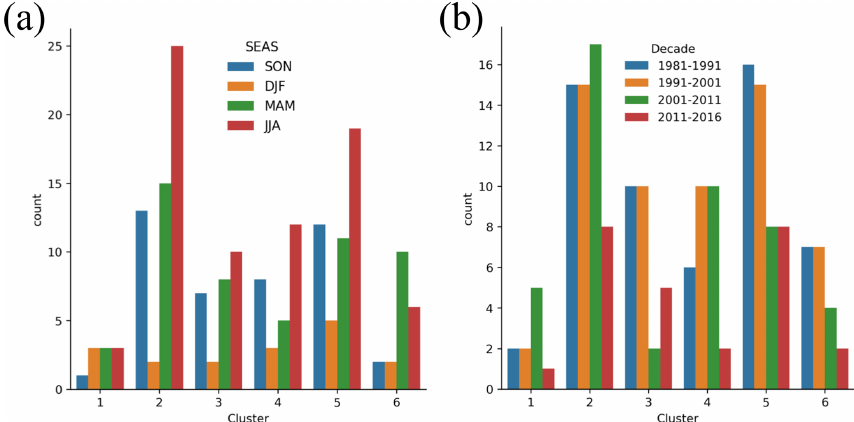
Figure 12. (a) MHW macroevents by season for each cluster. (b) MHW macroevents by decade for each